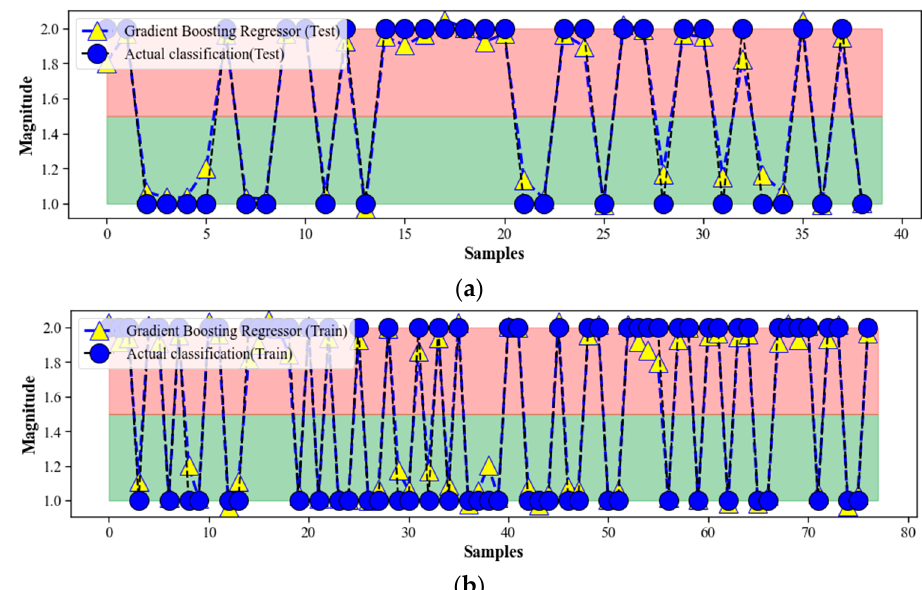
Figure 10. The GBA technique’s ability to detect breast cancer is demonstrated through its applica- tion on both training and testing data. ( a ) The accuracy of the technique on the training data is demonstrated. ( b ) The testing data are utilized to evaluate the method.